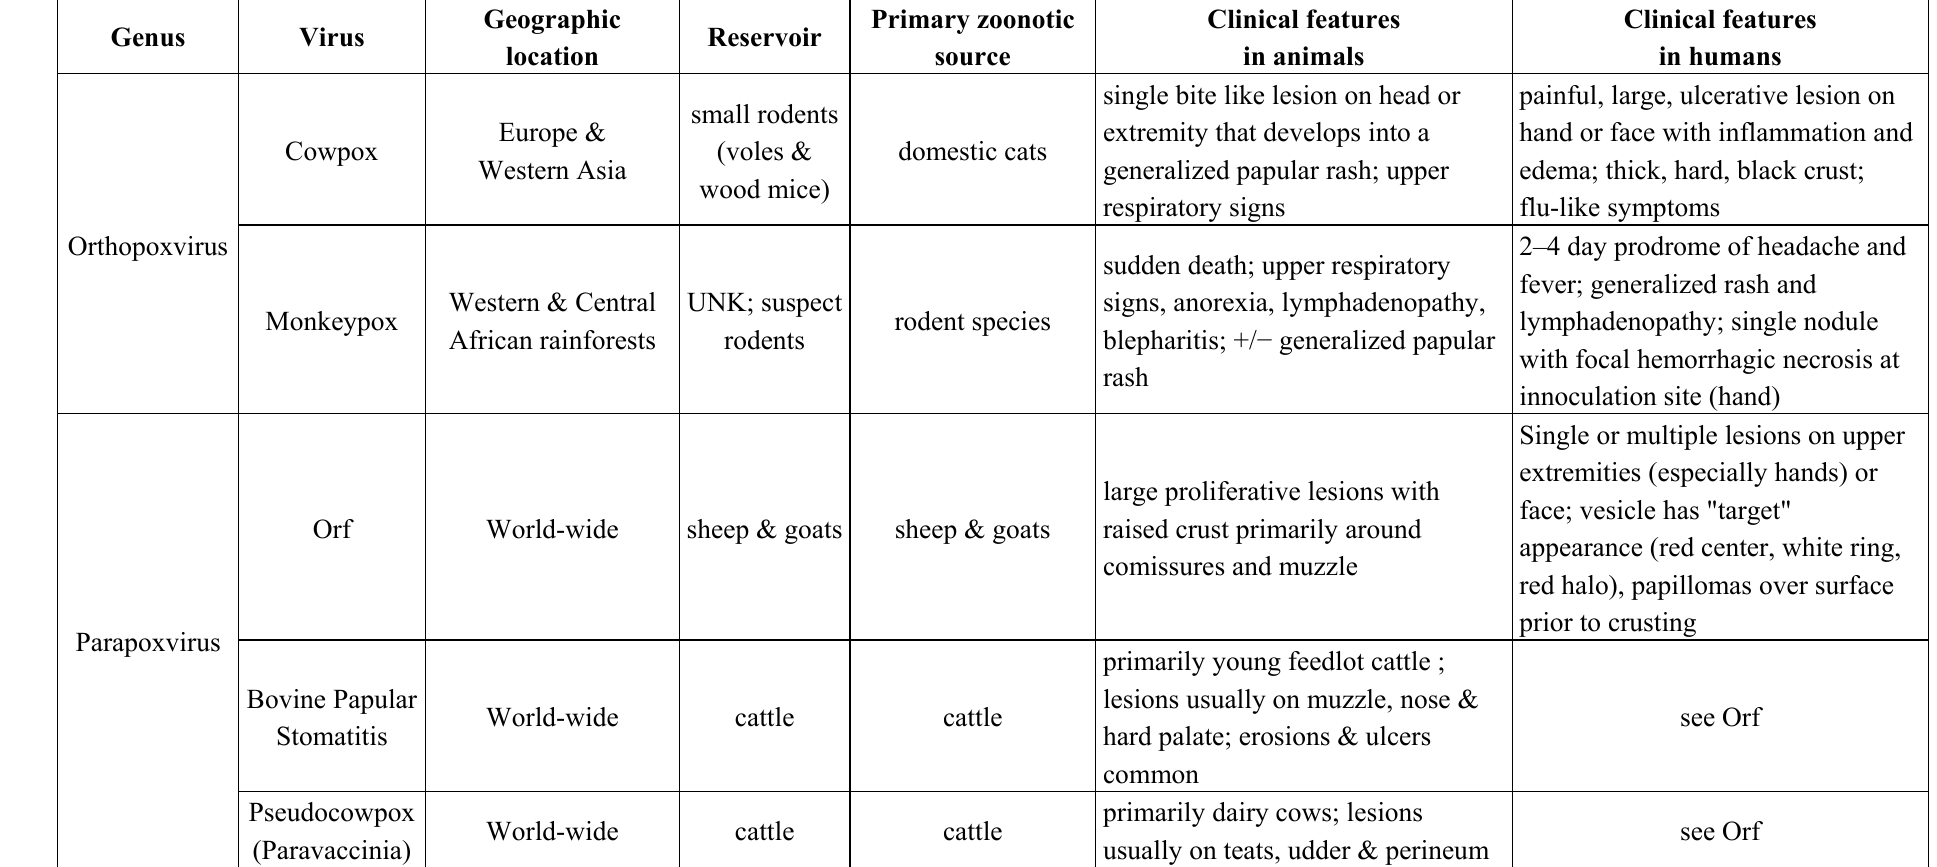
Table 1. Select zoonotic poxviruses and their associated distribution and clinical